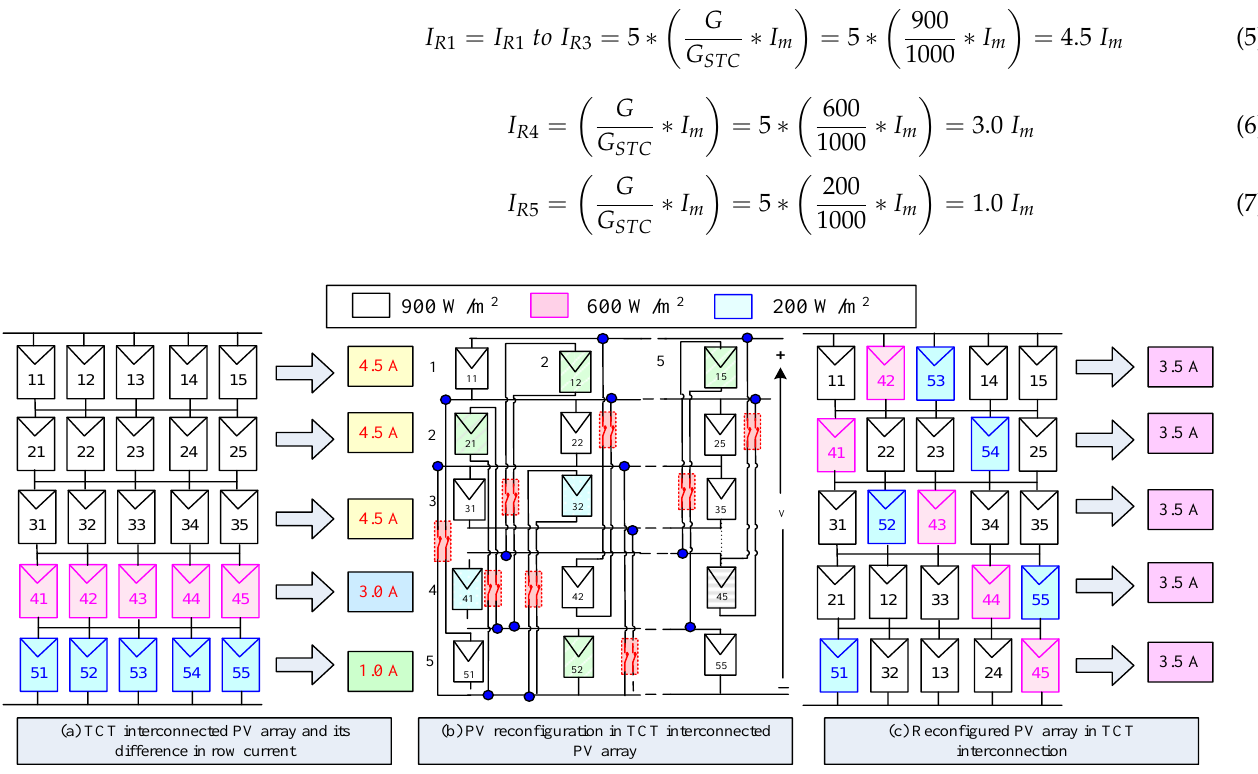
Figure 1. Reconfiguration process in PV array.